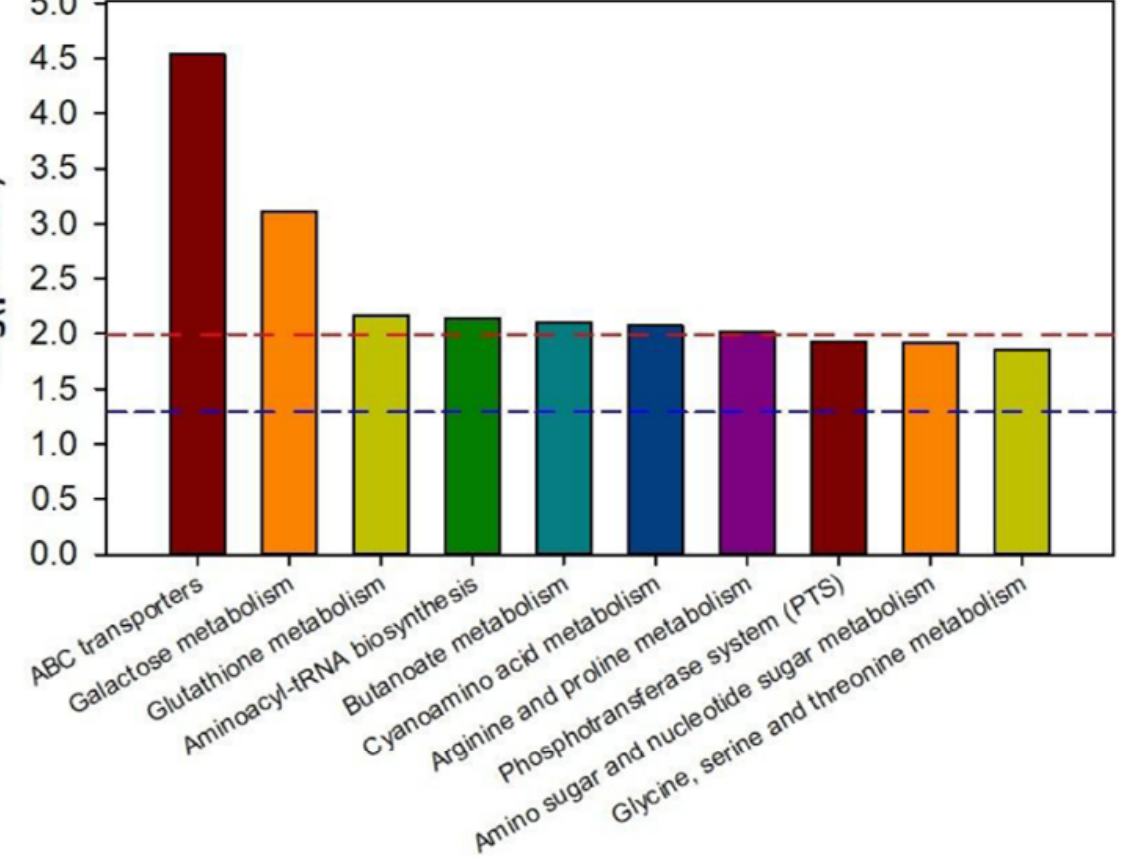
Figure 7. Metabolic pathway enrichment map of different metabolites in bayberry rhizosphere soil of the humic acid treatment. LD and HA represent the absence and presence of humic acid in diseased bayberry trees, respectively. The signal pathway is significant when the top of the bar is higher than the blue ( p < 0.05) or red line ( p <